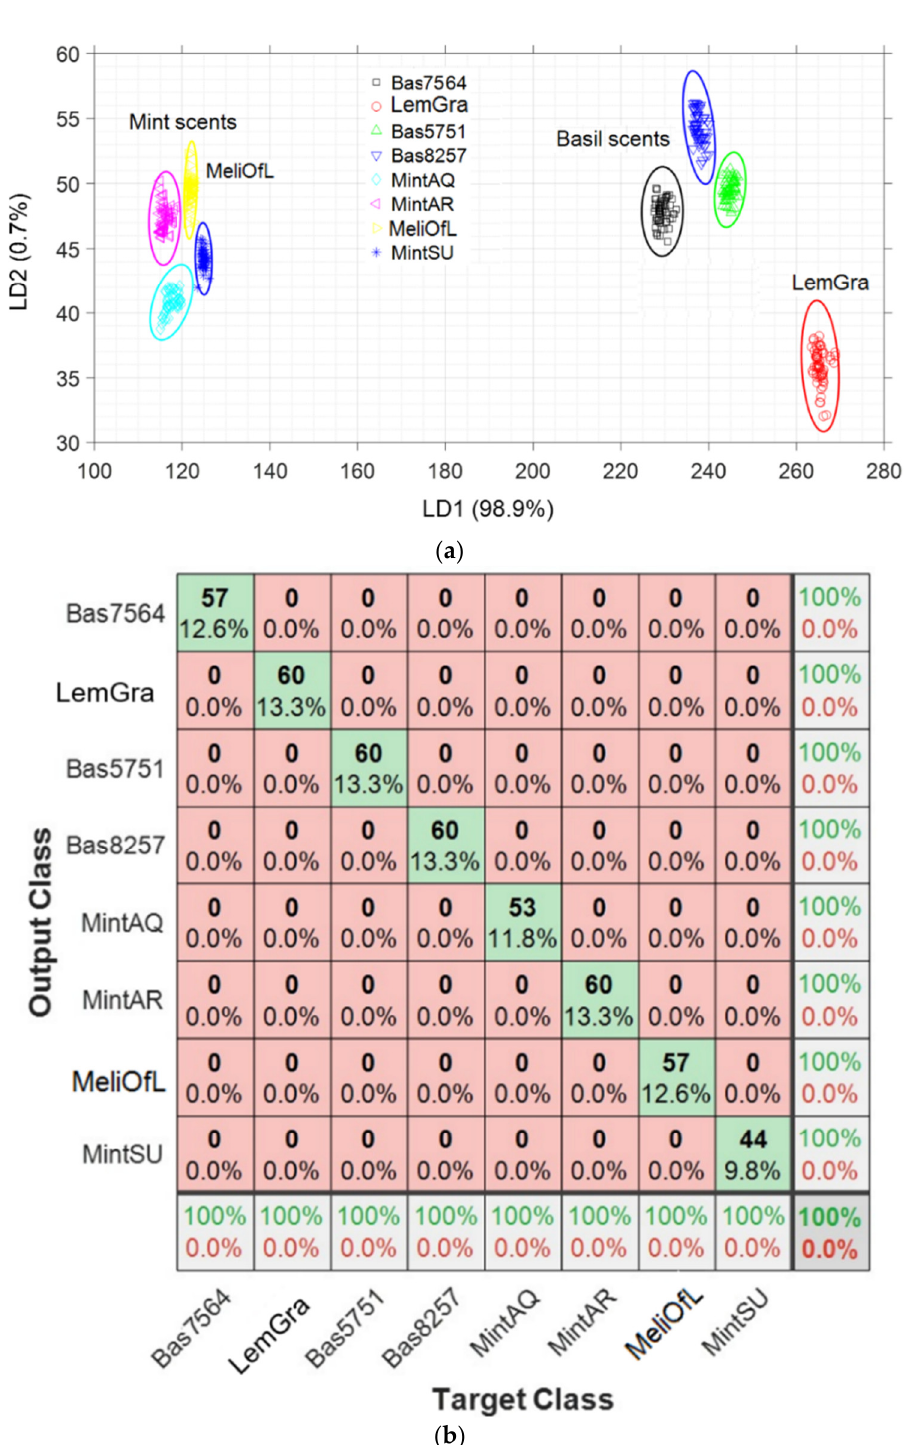
Figure 7. Linear discriminant analysis of eight species: ( a ) 2D plot of the linear discriminant analysis with 95% confidence ellipse and ( b ) confusion matrix obtained from 10-fold LDA calculations using the training dataset obtained from the first cycle of the e-Nose measurements.